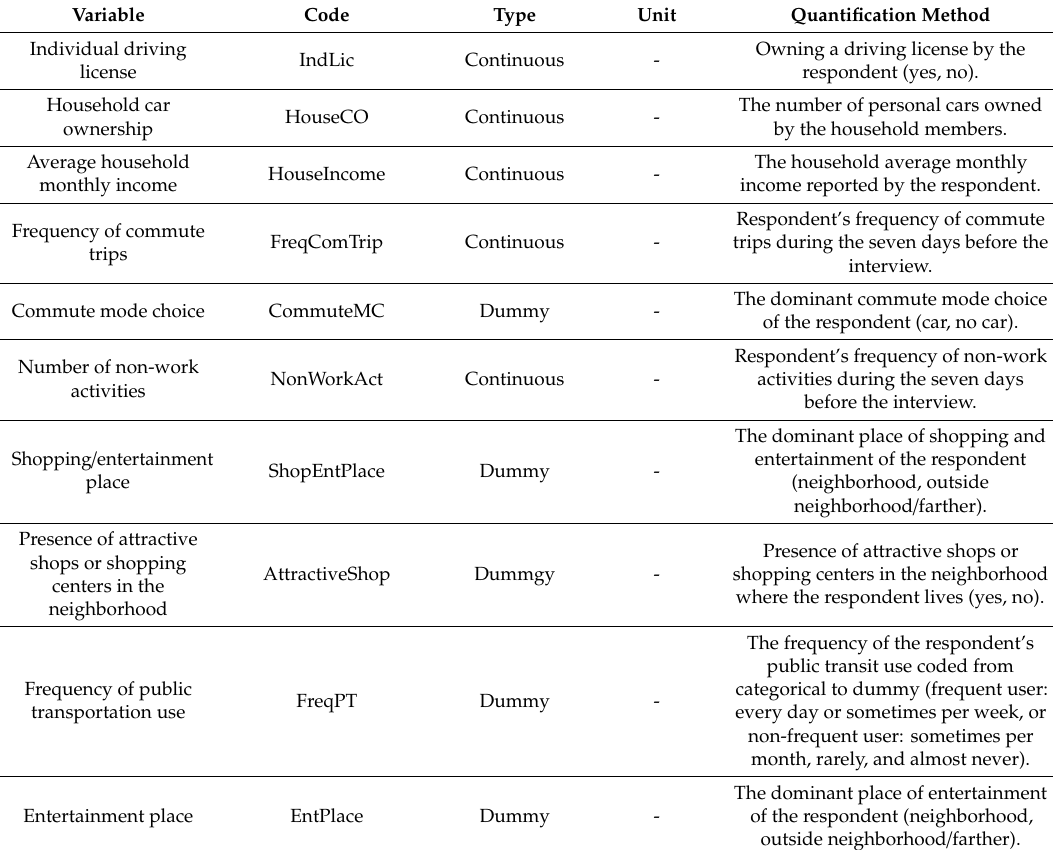
Table 4. Variables and quantification